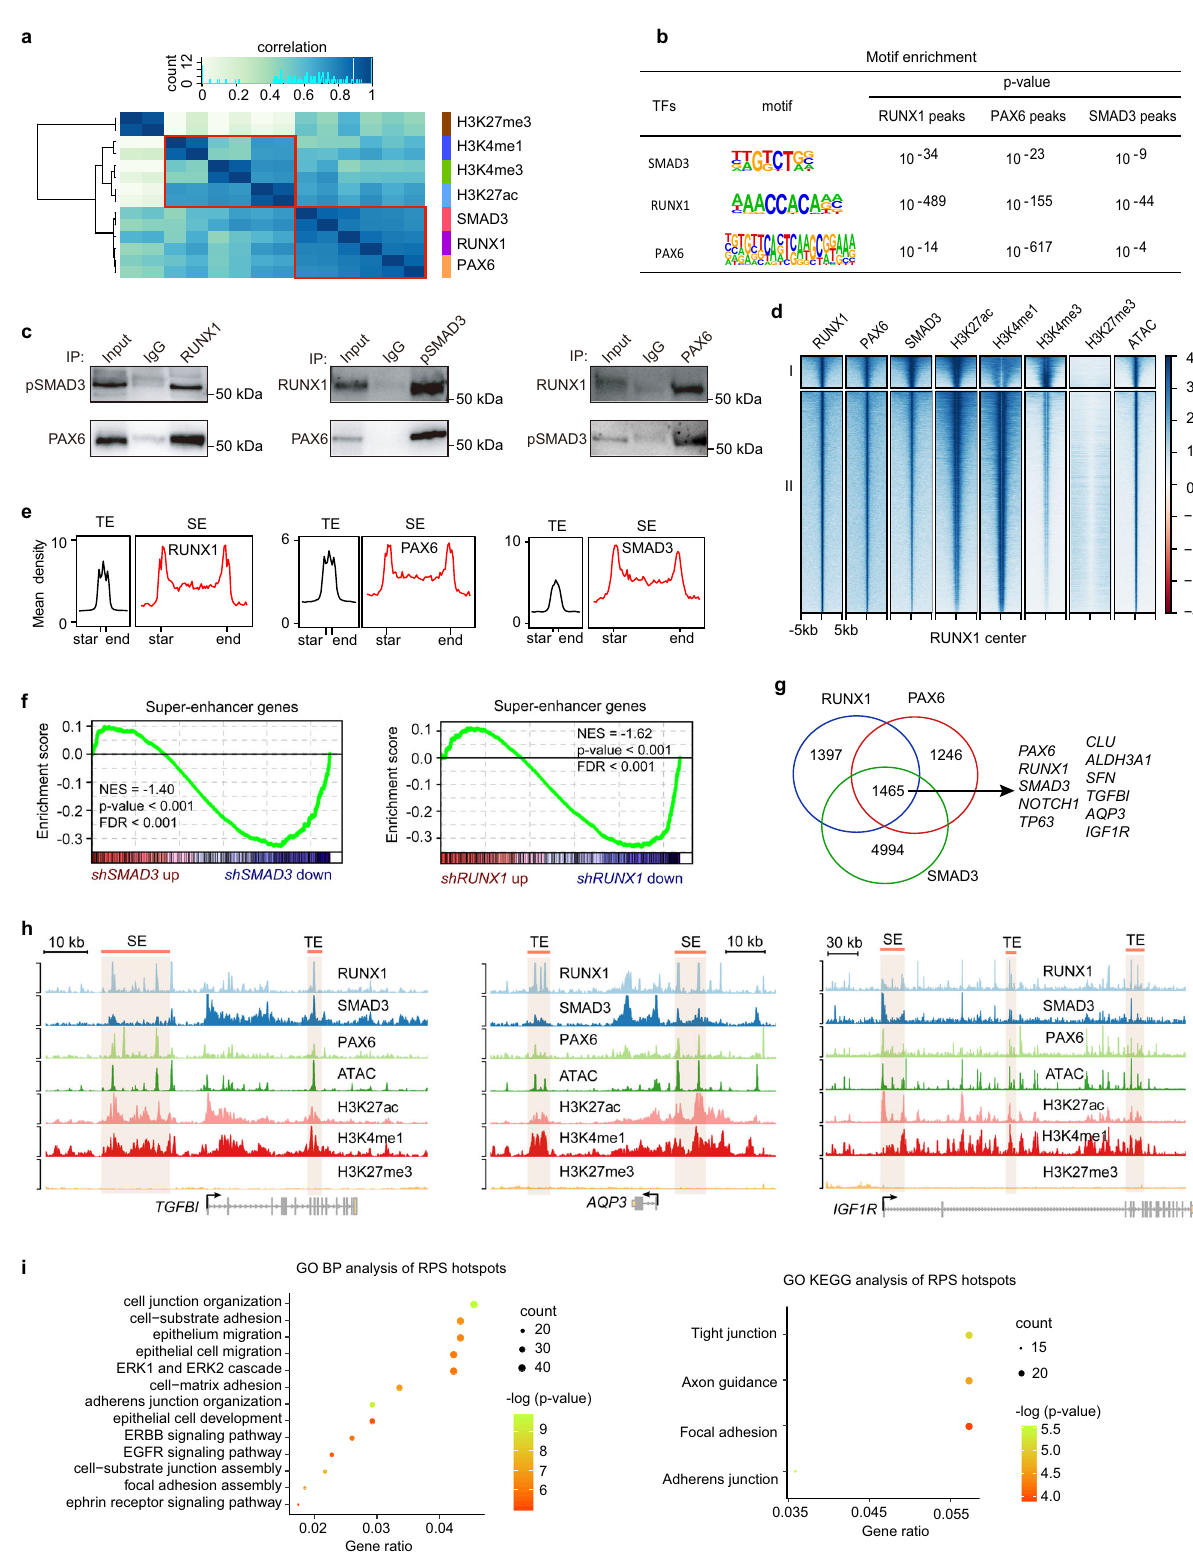
fold, false discovery rate [FDR] < 0.05) were identi fi ed upon RUNX1 depletion, almost all of which (98.5%, 22,237/22,576) showed diminished H3K27ac deposition (Fig. 5b). The peaks with decreased H3K27ac included 4331 sites (19.5%) in proximal promoters and 17,906 sites (80.5%) in distal enhancers (Supple- mentary Fig. 5b). Combined with RNA-seq data, we found that